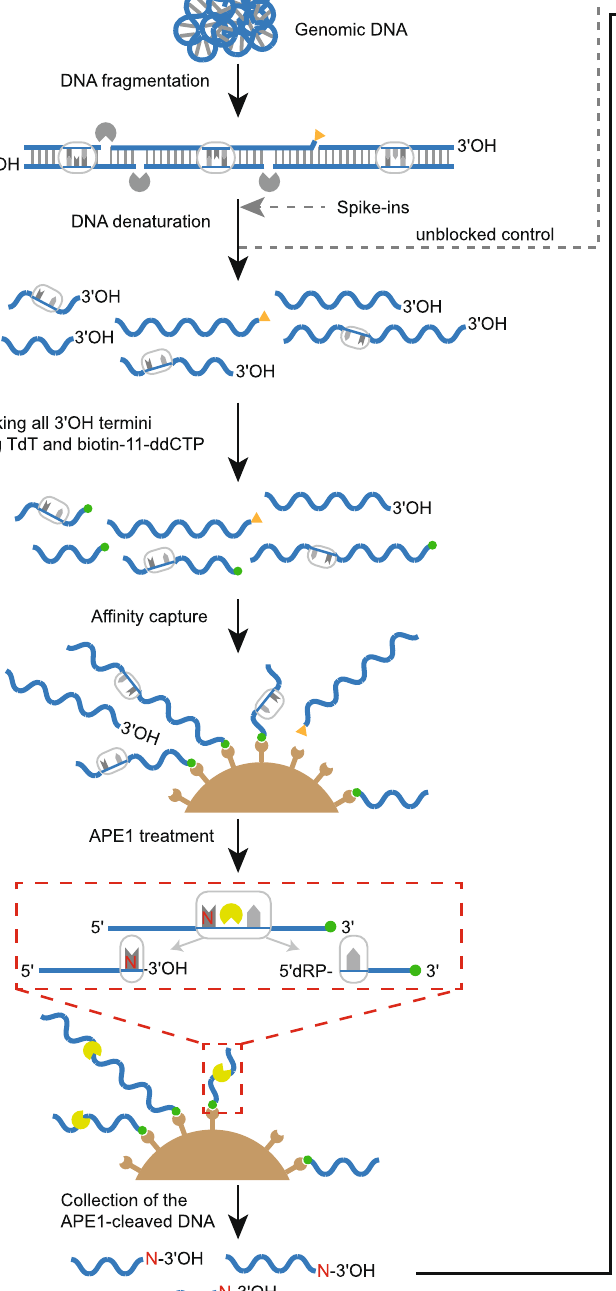
for Illumina (SSiNGLe-ILM) procedure starting with tagging the 3 ’ OH termini by polyA-tailing and subsequent NGS library preparation steps. Importantly, DNA moleculesinwhichthe3 ’ terminiwereblockedbyDNAdamage(suchasoxidated3 ’ ends) cannot be biotinylated and thus did not enter the APE1 treatment step. The spike-ins were added to DNA before denaturation, as shown. To generate the unblocked control, the denatured DNA was used as input into SSiNGLe-ILM, as shown after the addition of spike-ins. See Supplementary Fig. 1 for the description of the analytical parts of